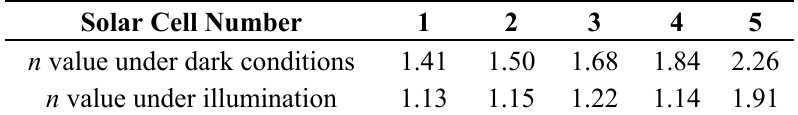
Table 3. The ideality factors for AlGaAs based graded bandgap solar cells under dark and illuminated conditions showing reduced recombination contributions under illumination.